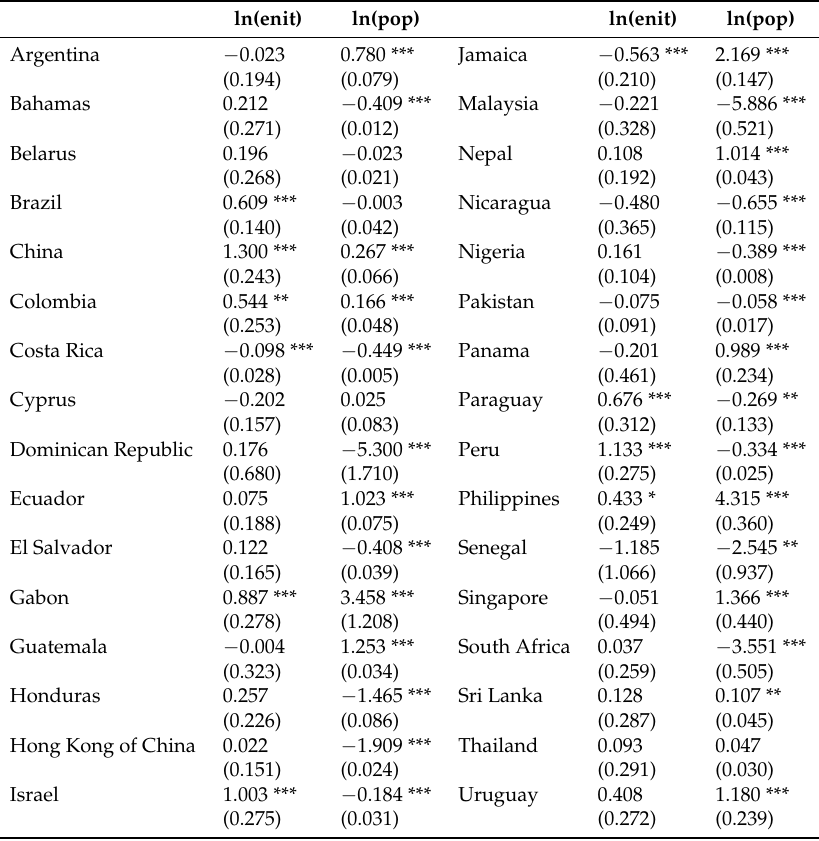
Table 7. Parametric estimates for the non-OECD countries. Semiparametric